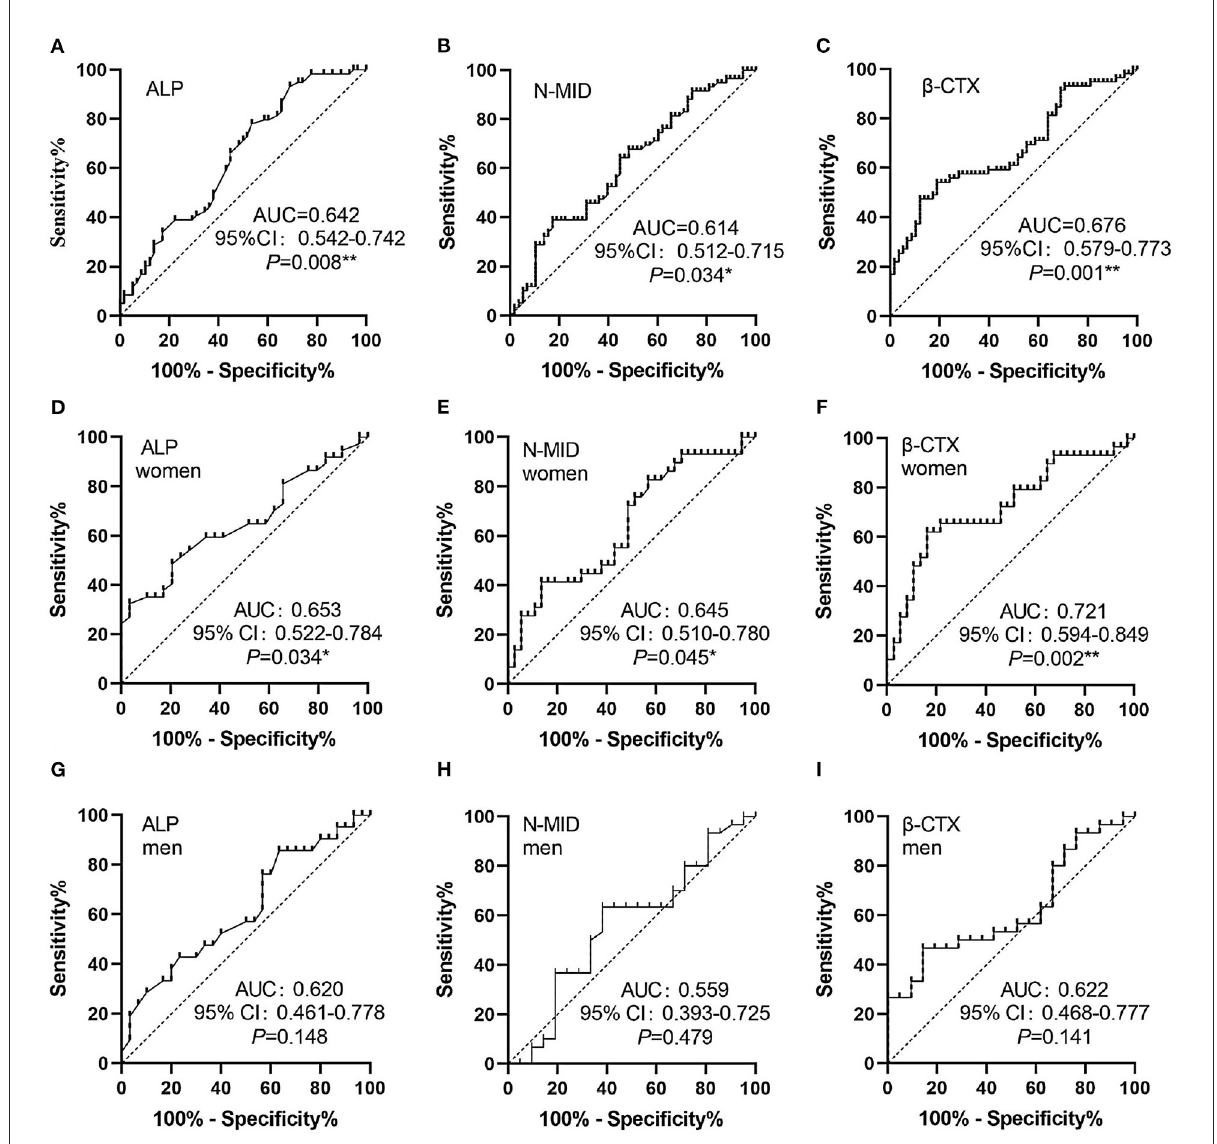
FIGURE4 ROC curves. (A–C) ROC curves of ALP, N-MID and β -CTX, respectively. (D–F) ROC curves of ALP, N-MID and β -CTX in women SSNHL, respectively. (G–I) ROC curves of ALP, N-MID and β -CTX in men SSNHL, respectively. *0.01 ≤ P < 0.05, **0.001 ≤ P < 0.01. AUC, areas under the curves; ALP, Alkaline phosphatase; N-MID, N-terminal-midfragment of osteocalcin; β -CTX, β -carboxy terminal crosslinked telopeptide of type 1 collage.